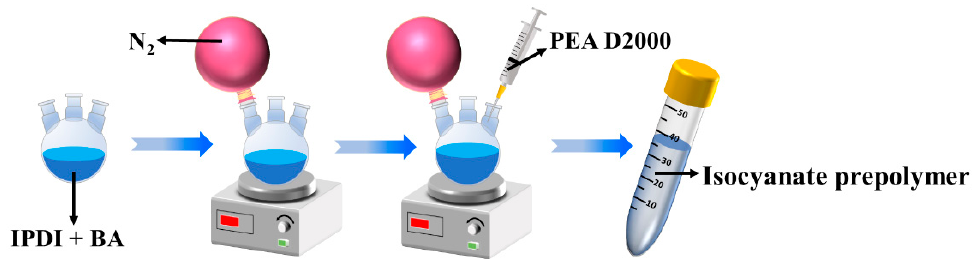
Figure 1. Schematic diagram of synthesis of isocyanate prepolymer.